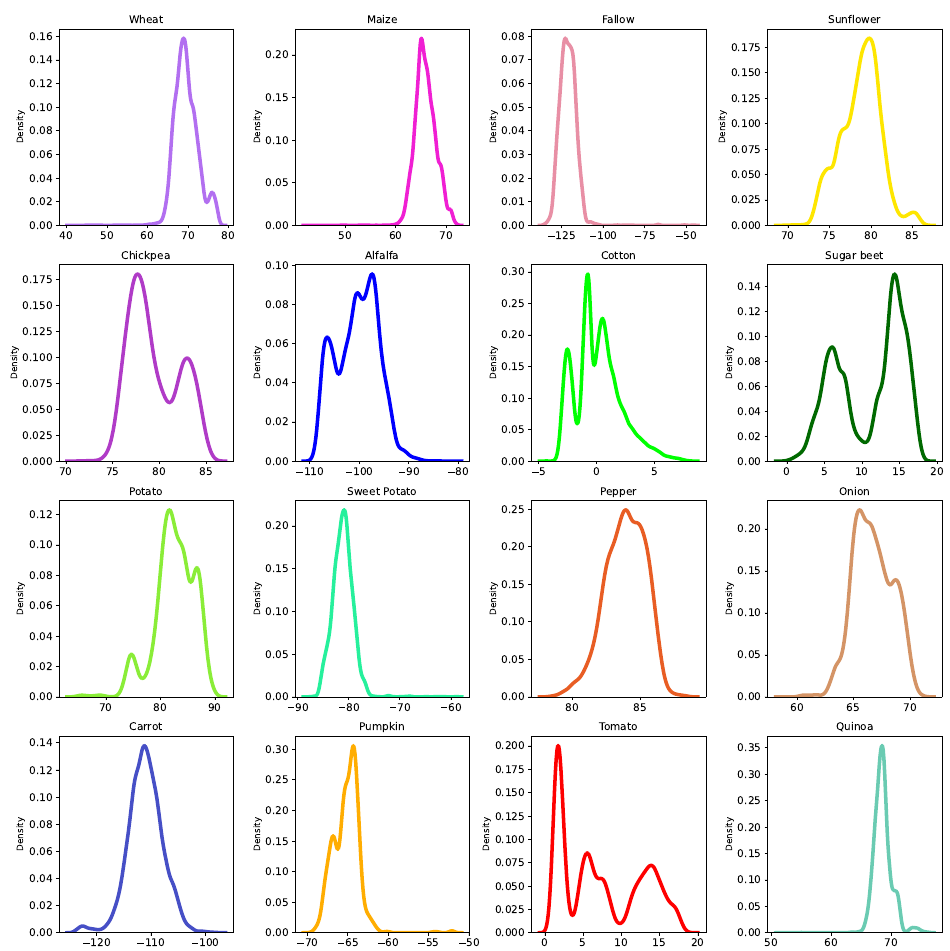
Figure A1. Density plots of each class 1D latent space after class-expert training for dataset correction, estimated using a kernel density